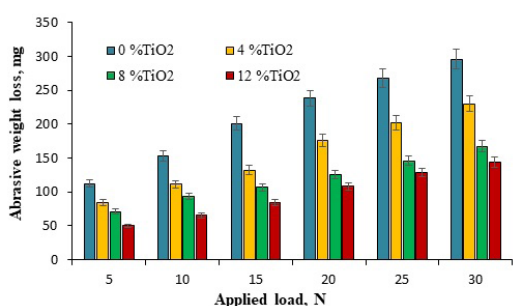
Figure 12. Correlation between abrasive weight loss (mg) and applied loads at different nano-TiO2 contents and sliding distance of